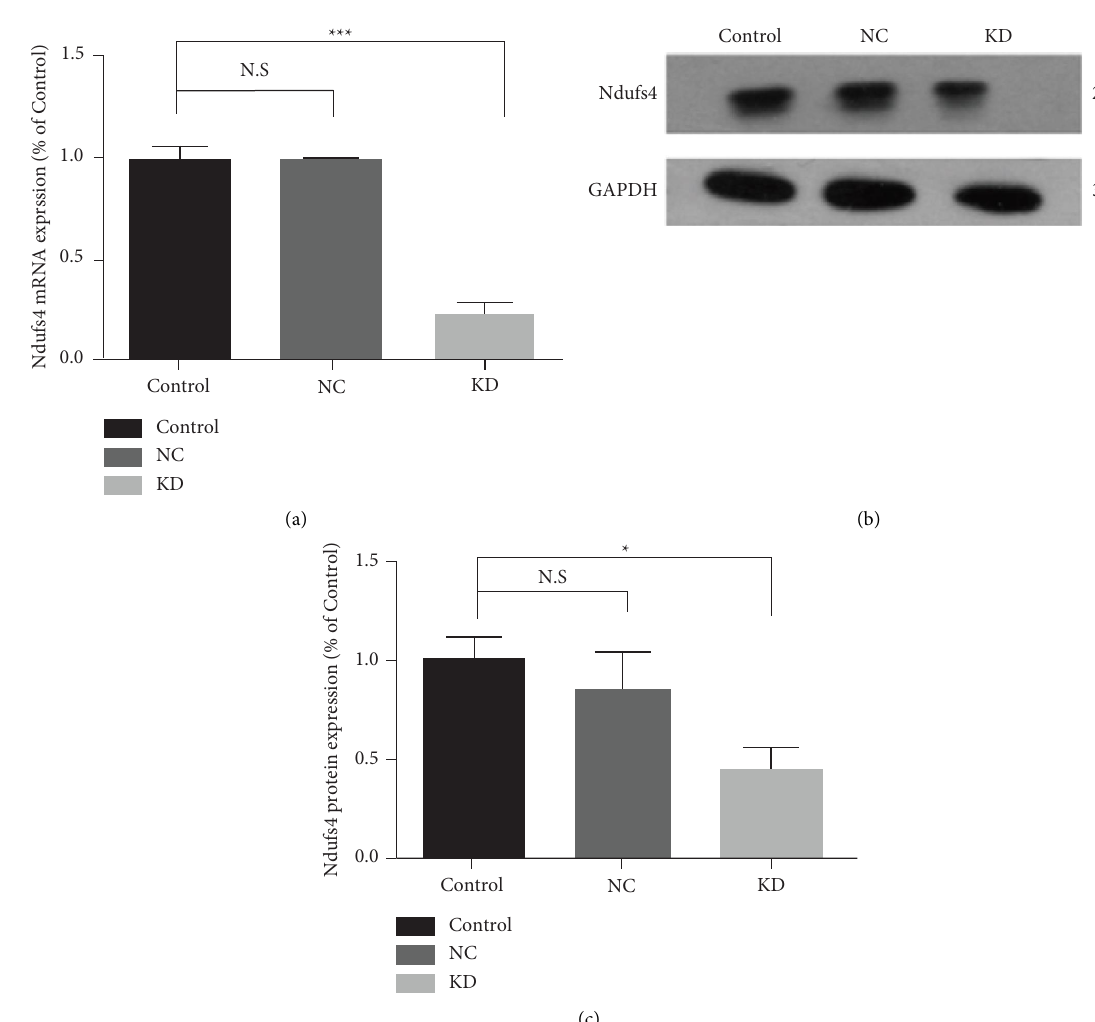
Figure 4: Ndufs4 gene was knocked down evidently. (a) Te relative level of Ndufs4 mRNA in infected H9c2 cells was decreased by 76.7% versus the control group ( P < 0 . 001). Tere was no signifcant diference between the control group and the NC group. (b, c) Western blot and quantitative evaluation of the expression of Ndufs4 gene in infected H9c2 cell lines. Te protein content of Ndufs4 in the KD group decreased by 64.9% ( P < 0 . 05) compared with the control group, and there was no signifcant diference between the control group and the NC group. Data were expressed as mean ± SD ( n � 3). ∗ P versus the control group; ∗ P < 0 . 05 and ∗∗∗ P < 0 .